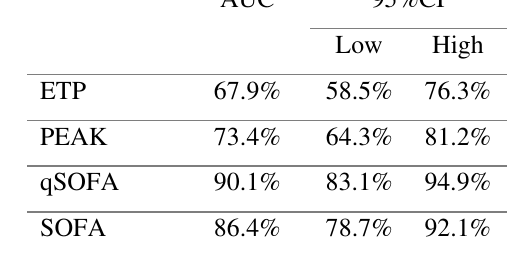
Figure 3. Under the ROC curve for the correlation of thrombin generation, qSOFA, SOFA and mortality. The diagnostic ability of thrombin generation values, qSOFA and SOFA in predicting mortality in sepsis. ROC, receiver operating characteristic. AUC area under curve. CI confidence interval. qSOFA quick sequential organ failure assessment. SOFA sequential organ failure assessment. ETP endogenous thrombin